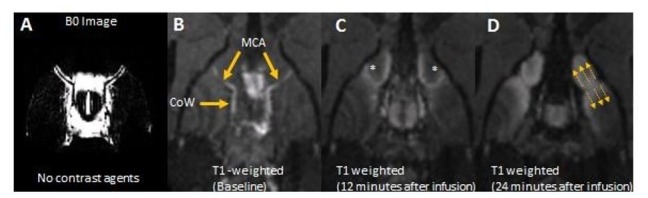
Comparison to contrast enhanced MRI following cisterna magna injection of gadoliniumA. b0 image at the ventral aspect of the rat brain captured using the noninvasive approach with an ultra-long TE. B. T1 weighted image at the matched ventral slice at baseline, prior to intra-cisternal gadolinium infusion. T1 weighted images 12 minutes (C) and 24 minutes (D) after intra-cisternal gadolinium infusion.